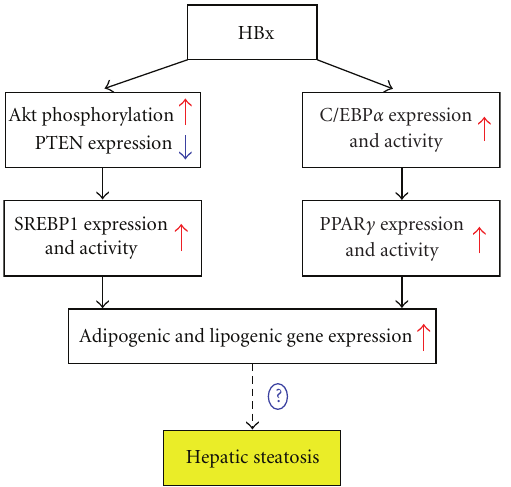
Figure 3: HBx protein could influence liver steatosis through SREBP1 and PPAR γ . Protein X of the HBV (HBx) increases the kinase AKT phosphorylation and inhibits PTEN expression that leads to increased expression and activation of SREBP1 in the liver. In another way HBx enhances C/EBP α that in turn induces PPAR γ expression and activation. Both pathways lead to an increased expression of adipogenic and lipogenic genes, which finally could contribute to liver